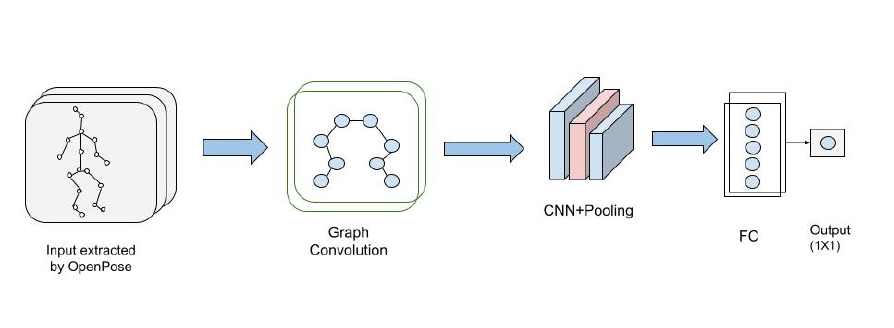
Figure 3. The proposed graph convolutional neural network (GCNN).